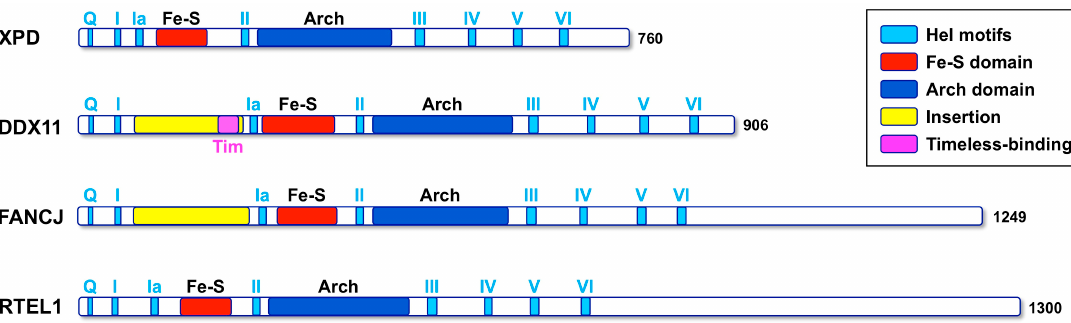
Figure 1. Schematic representation of the architecture of the human Fe–S DNA helicases. The colour code for the domains and motifs is shown in the inset. The conserved helicase motifs are shown in light blue ; box I and II correspond to the canonical ATPases Walker A and Walker B motifs. The characteristic Fe–S and Arch domain are shown in red and blue , respectively. Two partially unstructured insertions (shown in yellow ) are present in FANCJ and DDX11, between motifs I and Ia; the region in DDX11 that has been shown to interact with Timeless (in magenta ) is located within this insertion.